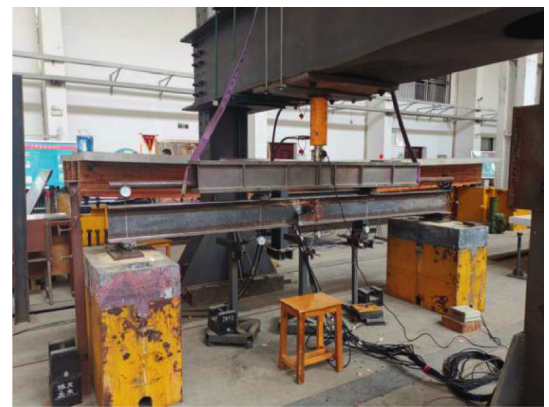
Figure 3: Loading device.